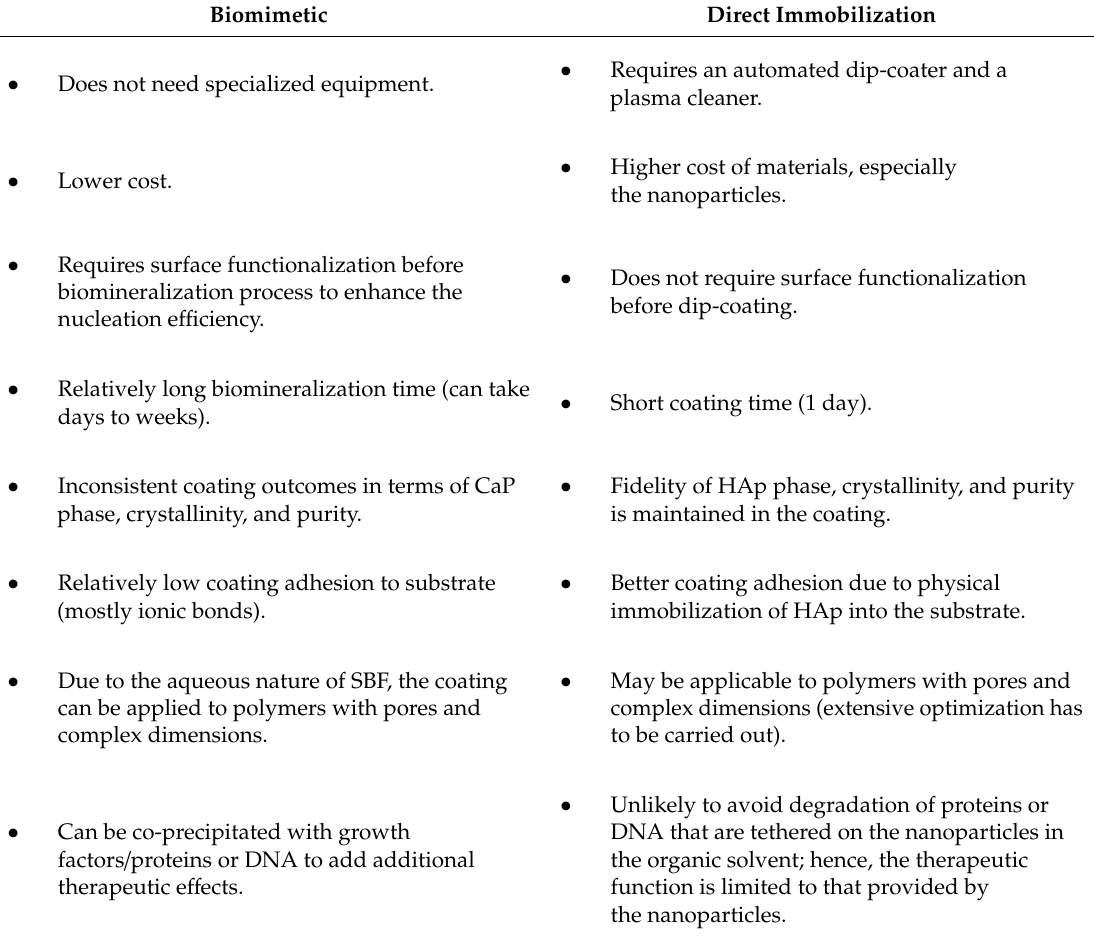
Table 2. Advantages and disadvantages of biomimetic deposition and direct immobilization of HAp